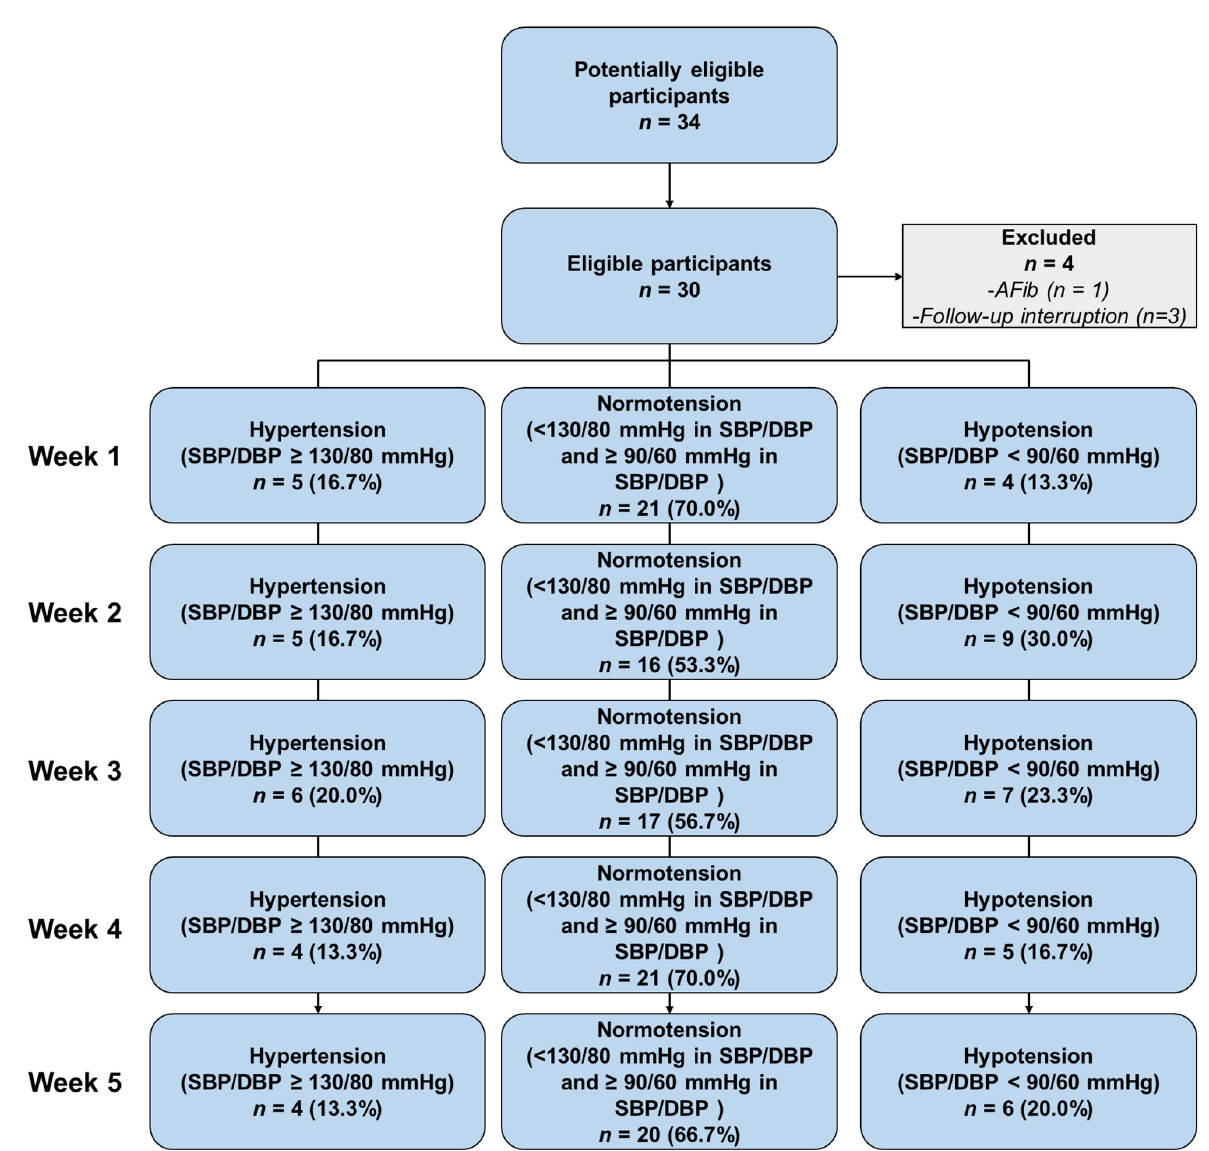
Figure 5. Flowchat of 1-month follow-up, based on the STARD 2015 guidelines. Eligible participants without AFib and follow-up interruption were divided into three groups: hypertension, normoten- sion, and hypotension. Weeks 1–5 showed similar partitions (hypertension: 13.3–20%; normotension: 53.3–70%; hypotension: 13.3–23.3%), validating the long-term data set. 3.2. Comparison of PPG Signals from Upper-Arm, Cuffless PPG BPM and Wrist-Type PPG BPM The characteristics of the PPG signals and their quality levels measured by the upper- arm and wrist-type BPMs from the same subject are shown in Figure 6. An excellent PPG signal was characterized by distinguishable systolic and diastolic peaks.